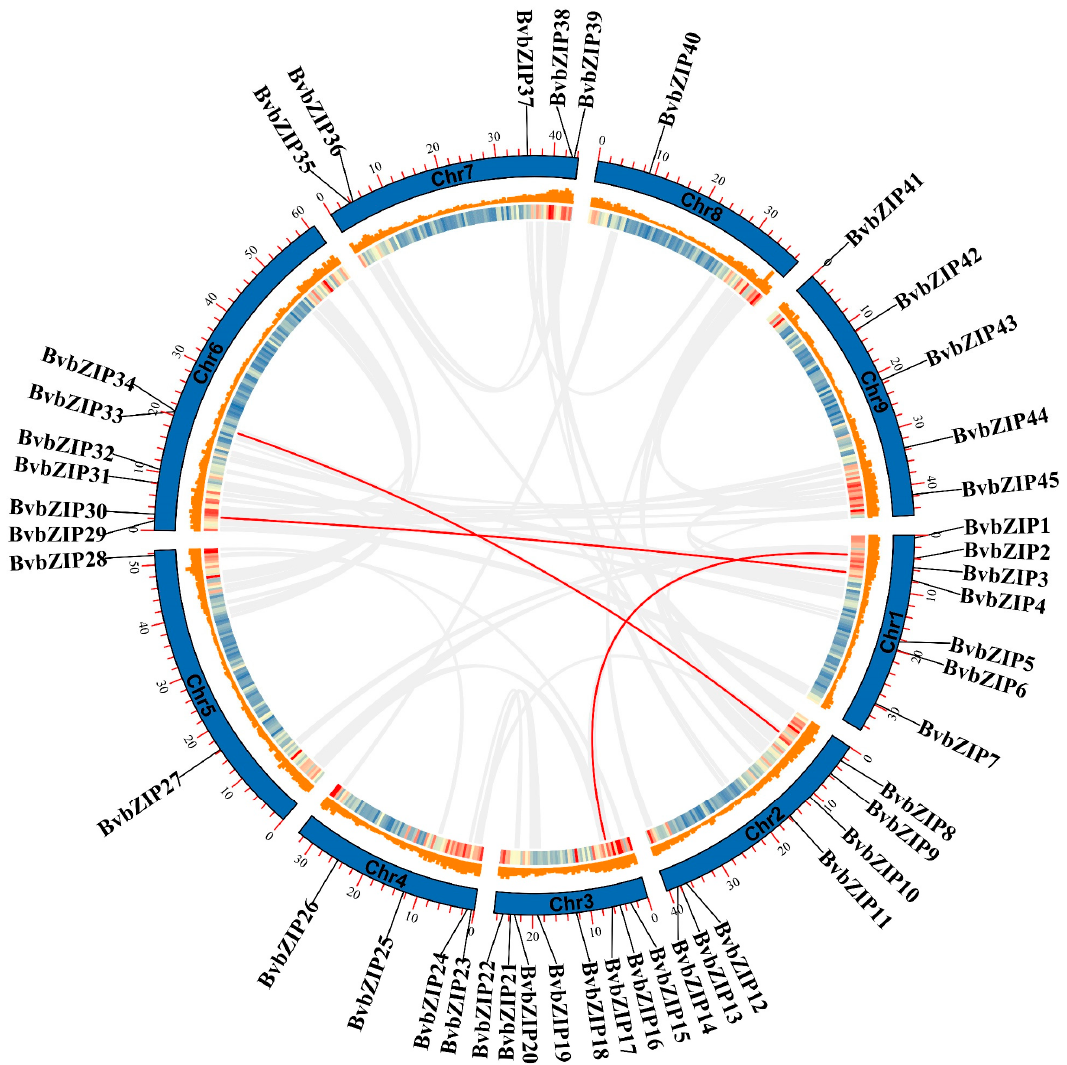
Figure 3. Chromosomal localization and collinearity analysis of BvbZIP genes. The outer circle represents the location information of BvbZIP genes on the chromosome, and the inner circle histogram and heat map represent the gene density and CDS density, respectively, on the sugar beet chromosome. The central line represents all fragment replication genes on the genome, and the red line connects the BvbZIP genes that had undergone fragment replication.